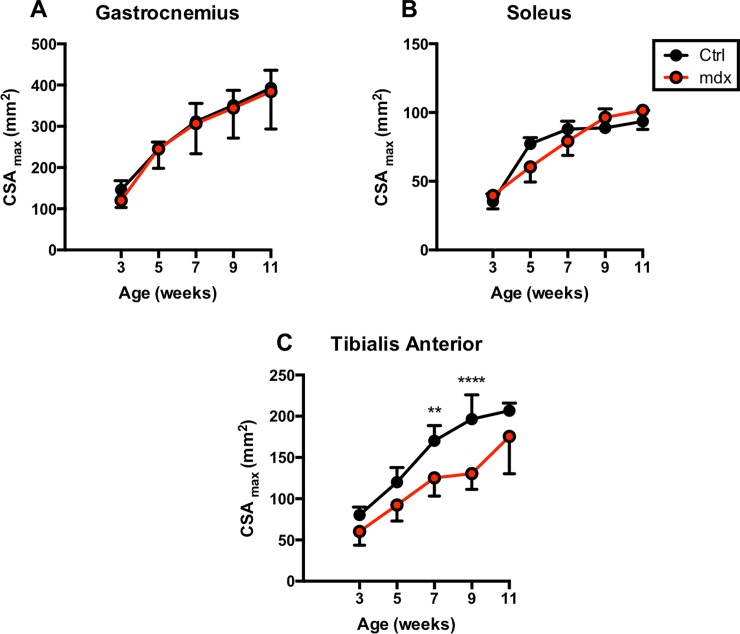
Cross-sectional area for GA, SOL, and TA muscles.Comparisons of muscle maximum cross-sectional area (CSAmax) between mdx4cv and control groups for GA, SOL, and TA muscles at each time point.